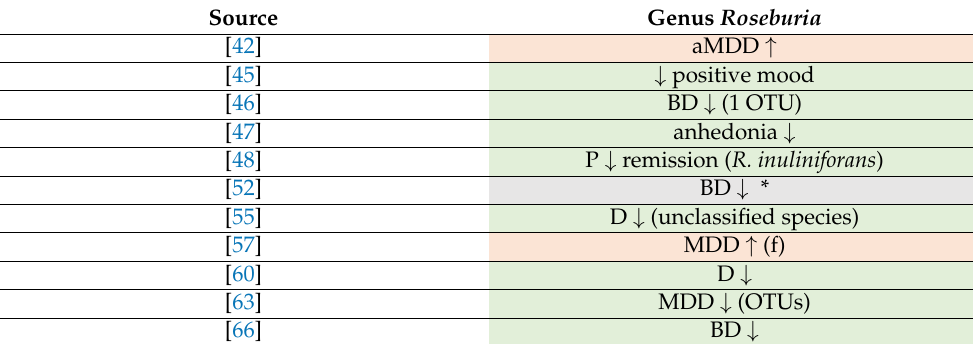
Table 4. Different abundance of genus Roseburia.